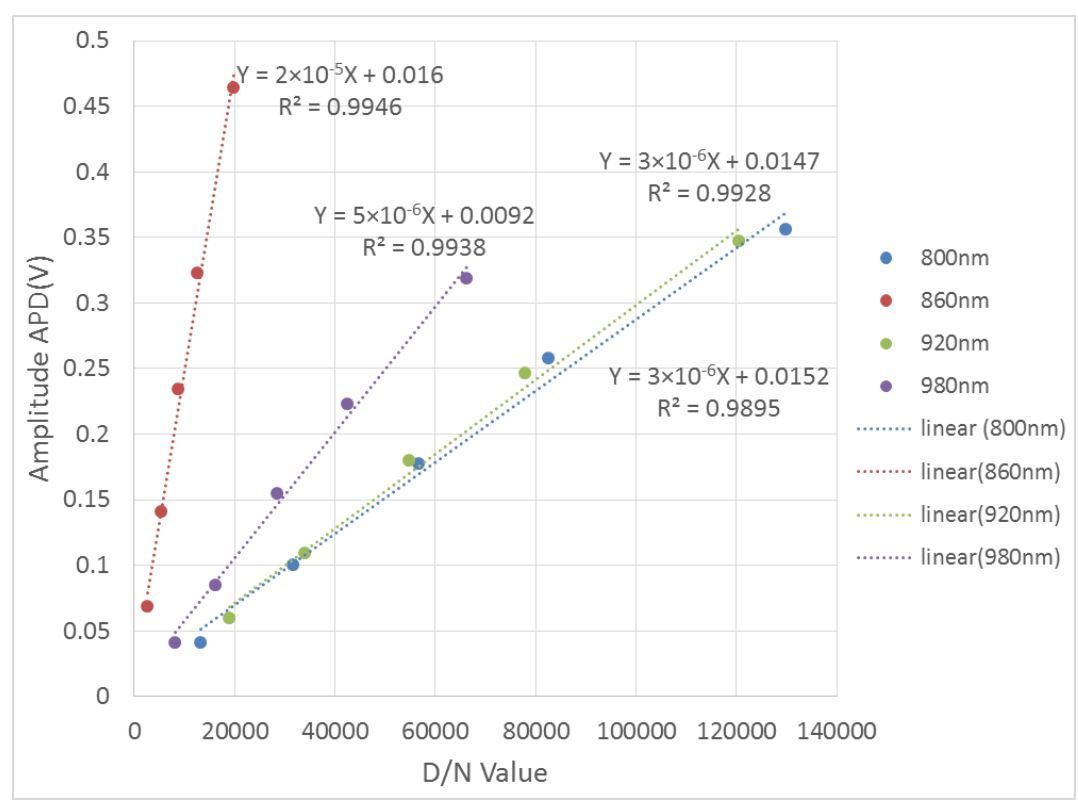
Figure 5. Relationship between AOTF-HSL measurement and spectrometer measurement in selected NIR bands.